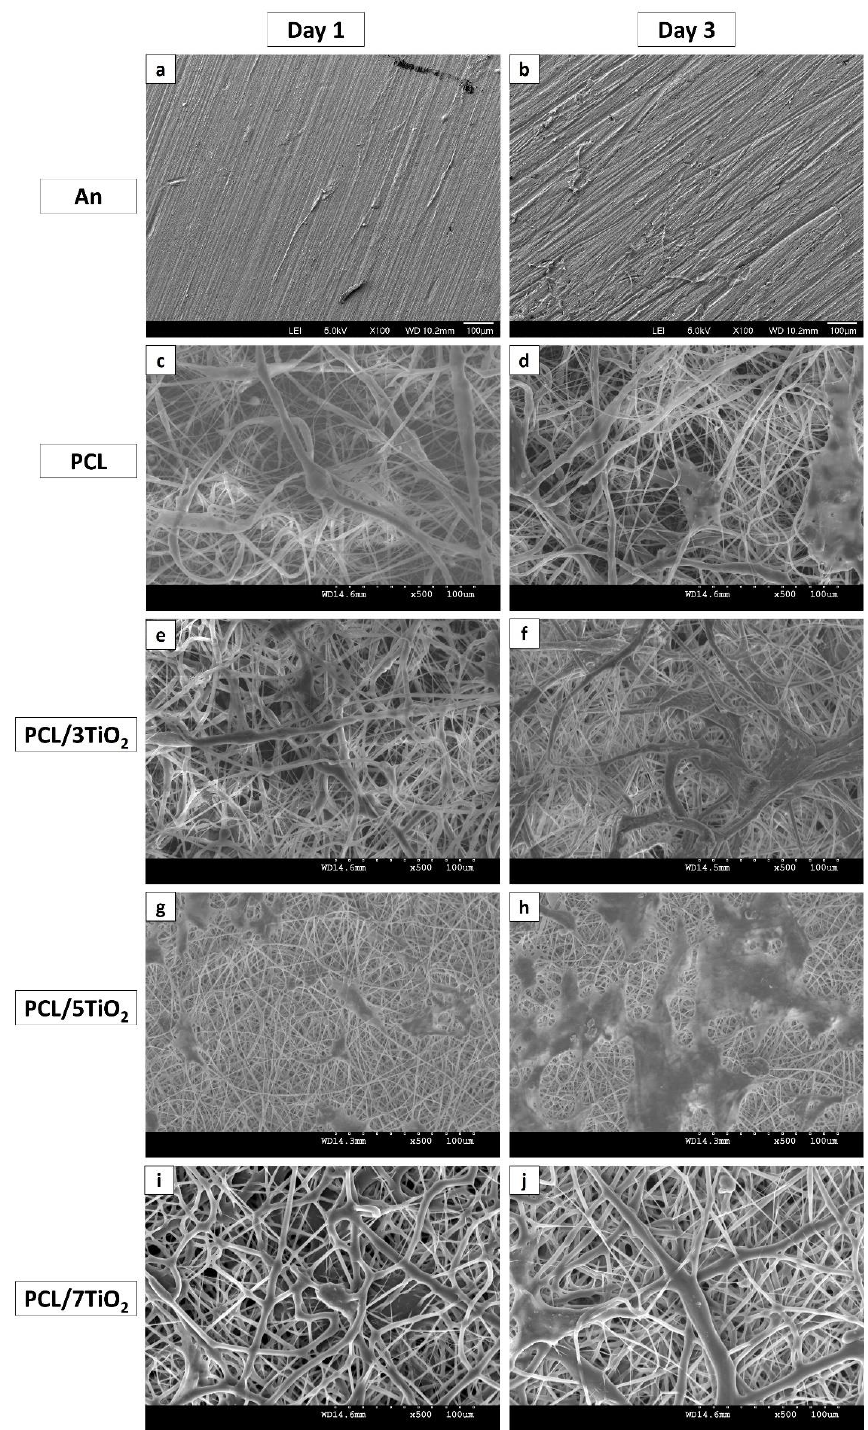
Figure 6. SEM images of hFOB cells seeded on various substrates after day 1, and day 3.